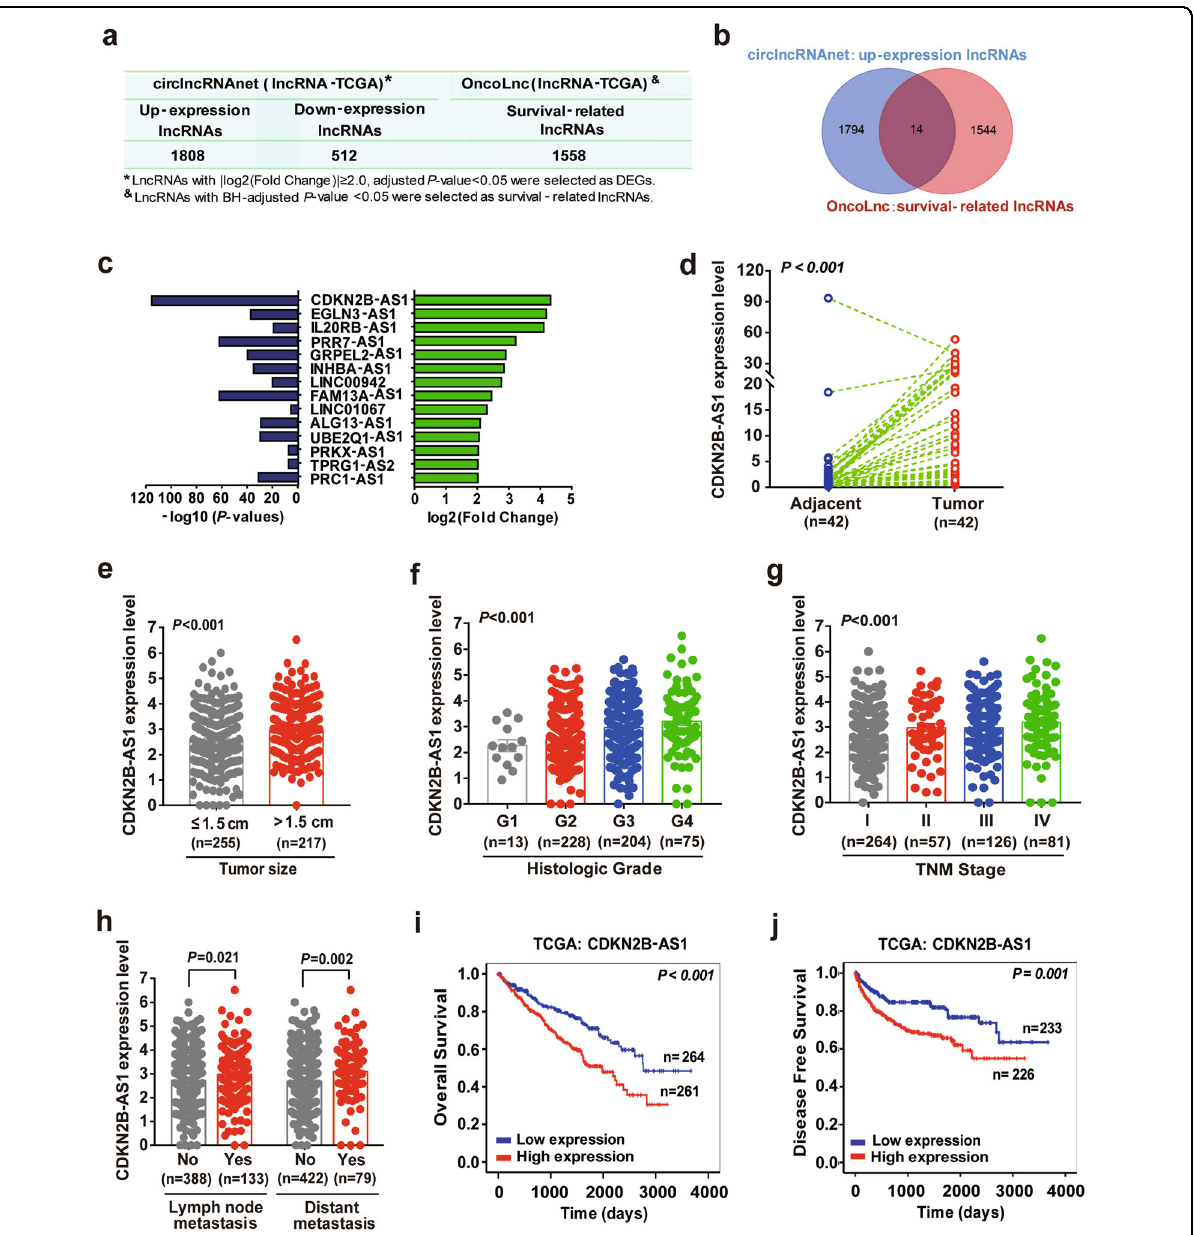
Fig. 1 Identi fi cation of an essential lncRNA CDKN2B-AS1 whose overexpression is associated with poor prognosis of KIRC. a Analysis of lncRNAs which were differentially expressed and related to KIRC survival in TCGA, using circlncRNAnet and OncoLnc database, respectively. b Venn diagram presenting the lncRNAs that were upregulated (1808 lncRNAs), related to survival (1558 lncRNAs), or both (14 lncRNAs) in KIRC. c The 14 lncRNAs which were upregulated and related to a shorter survival in KIRC. d qRT-PCR analysis of CDKN2B-AS1 expression in 42 paired KIRC tissues (tumor) and adjacent normal tissues (adjacent); β -actin was used as the internal control. e – h CDKN2B-AS1 expression was analyzed in KIRC patients regarding tumor size ( e ), histologic grade ( f ), TNM stage ( g ), and metastasis status ( h ), using RNA-seq data in TCGA. Error bars represent the SEM. i , j Kaplan – Meier analysis showed the overall survival and disease-free survival in KIRC patients based on the expression of CDKN2B-AS1 in TCGA dataset, the high and low expression groups were divided by the median of CDKN2B-AS1 levels. P value calculated by paired-sample t test ( d ), independent sample t test ( e , h ), one-way ANOVA ( f , g ), or log-rank test ( i , j